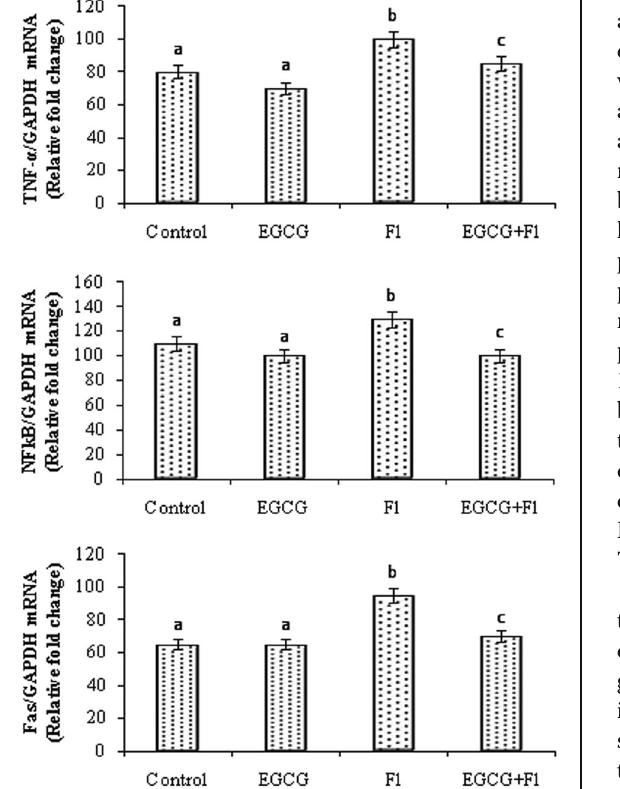
Fig. 8 Effect of EGCG on TNF- α , NF-kB, and Fas mRNA expression in the hippocampus of control and experimental rats. Values are mean ± SD for 6 rats in each group. a, b, c Values not sharing a common superscript letter (a, b, and c) differ significantly at p < 0.05